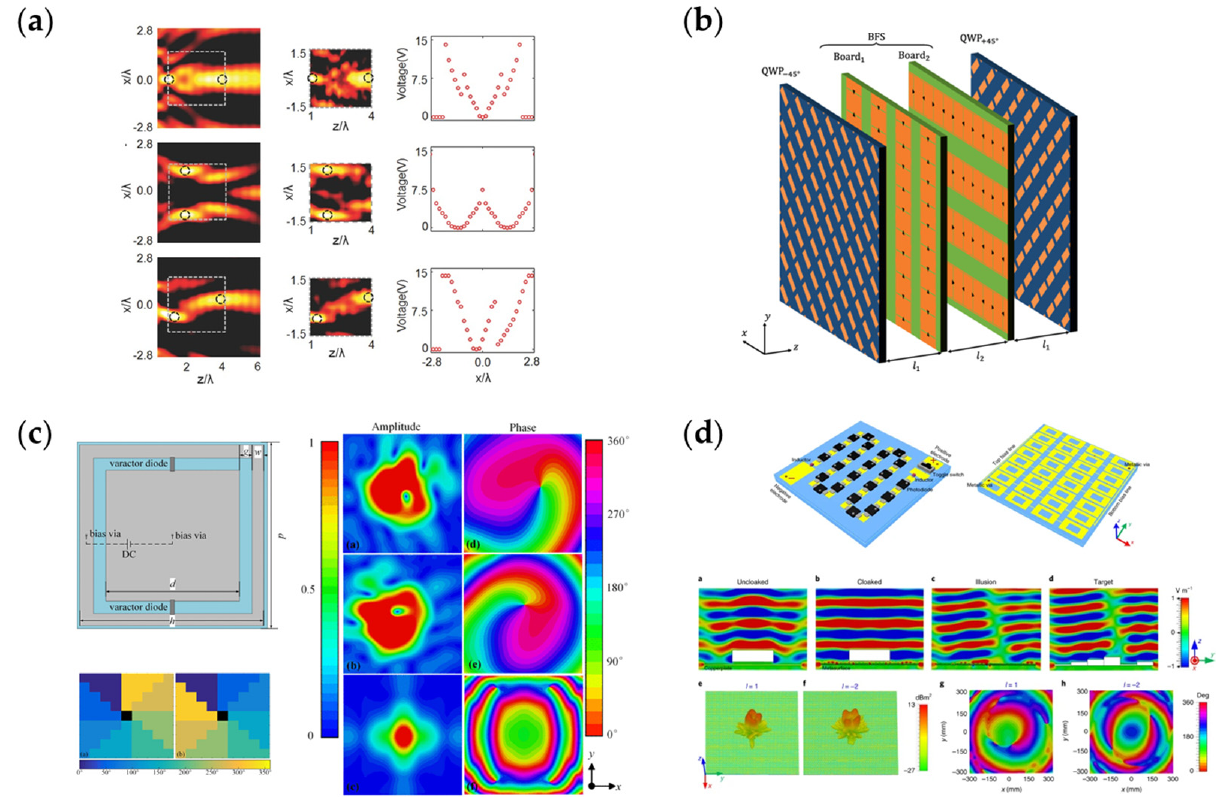
Figure 10. ( a ) A Huygens metalens, the focal point can be selected at any position in two-dimensional plane. Reprinted with permission from [241], copyright© 2000–2023 by John Wiley and Sons, Inc. or related companies. All rights reserved; ( b ) Multi-layer metasurface polarization rotator; ( c ) Metasurface loaded with varactors generating multiple modes vortex beams; ( d ) Light-controlled metasurface which can realize remote control. Reprinted with permission from [243], copyright 2023 Springer Nature.